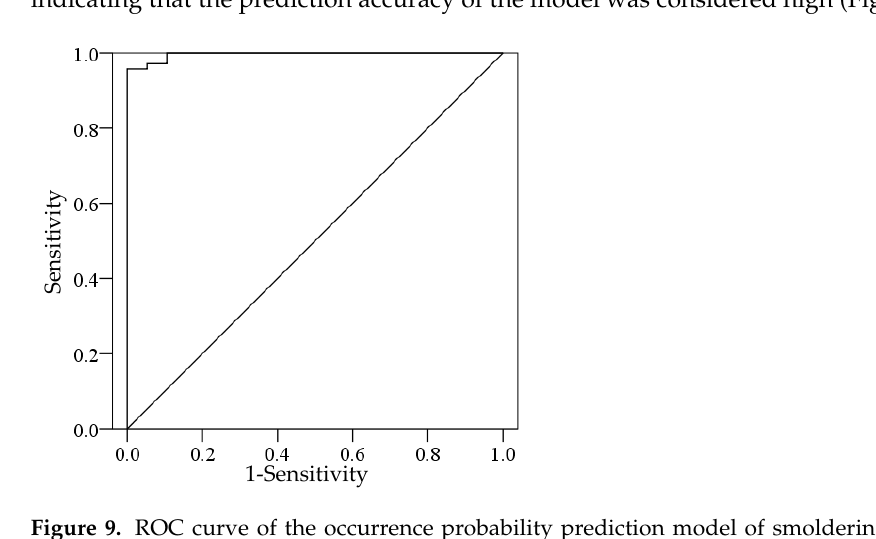
Table 3. Logistic regression fitting of occurrence probability during the sub-surface fire.